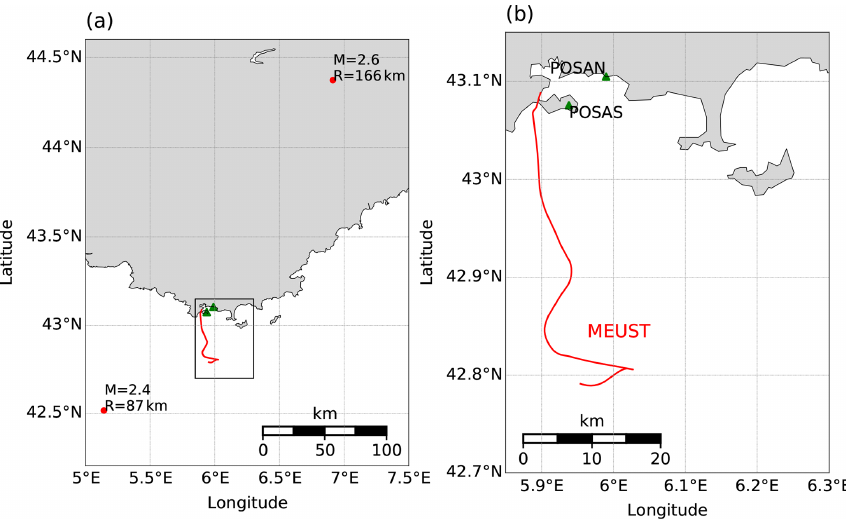
Figure A2. Map of earthquake, seismometer and cable locations in Toulon, southern France. The MEUST cable is indicated by a red line; recorded earthquakes are indicated by red circles. (a) Catalog magnitudes and hypocentral distances are indicated near earthquake locations. (b) The region marked by a black rectangle in (a) , with cable layout and broadband seismometers (green triangles).